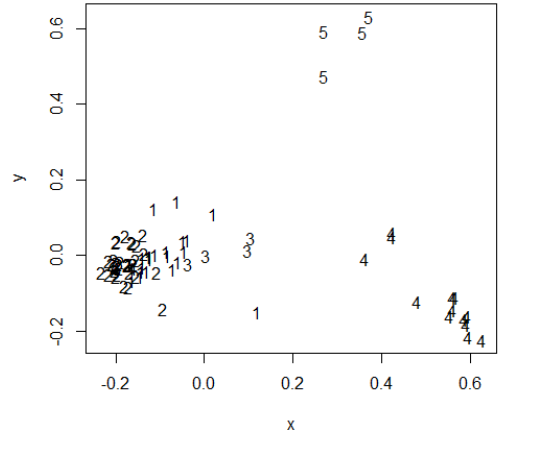
Figure 6. Location of the 5 clusters obtained with pam(k=5).